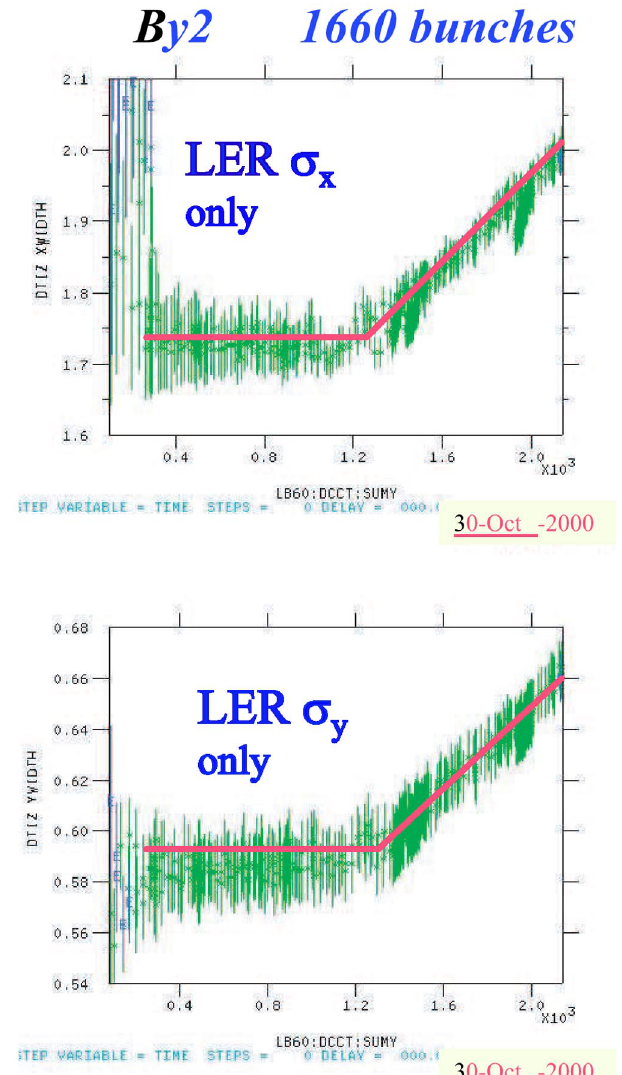
FIG. 16. (Color) Horizontal (top) and vertical beam size (bot- tom) of the PEP-II positron beam measured by synchrotron-light monitor on October 30, 2000, as a function of the total beam current in mA [104]; the horizontal scale extends from about 0.15 to 2.15 A; the beam consisted of 1660 bunches spaced by two rf buckets.